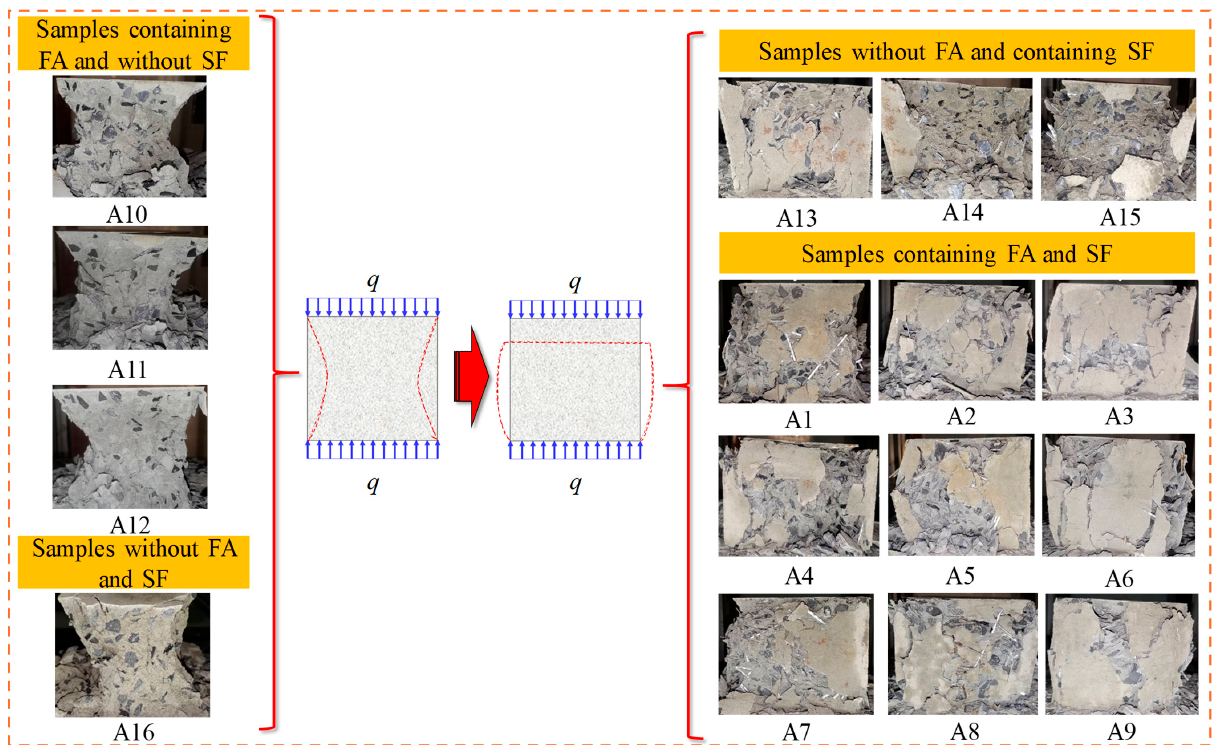
Figure 12. Brittle-ductility failure mode transformation of RBB samples.